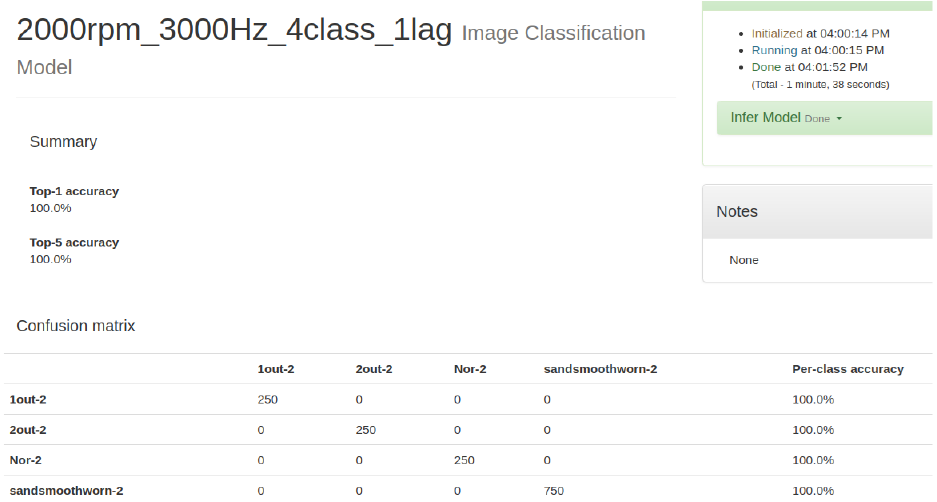
Figure 19. Confusion matrix for the improved formula of symmetrized dot pattern (SDP) as t = 1 (sampling at 3000 Hz / 2000 rpm).